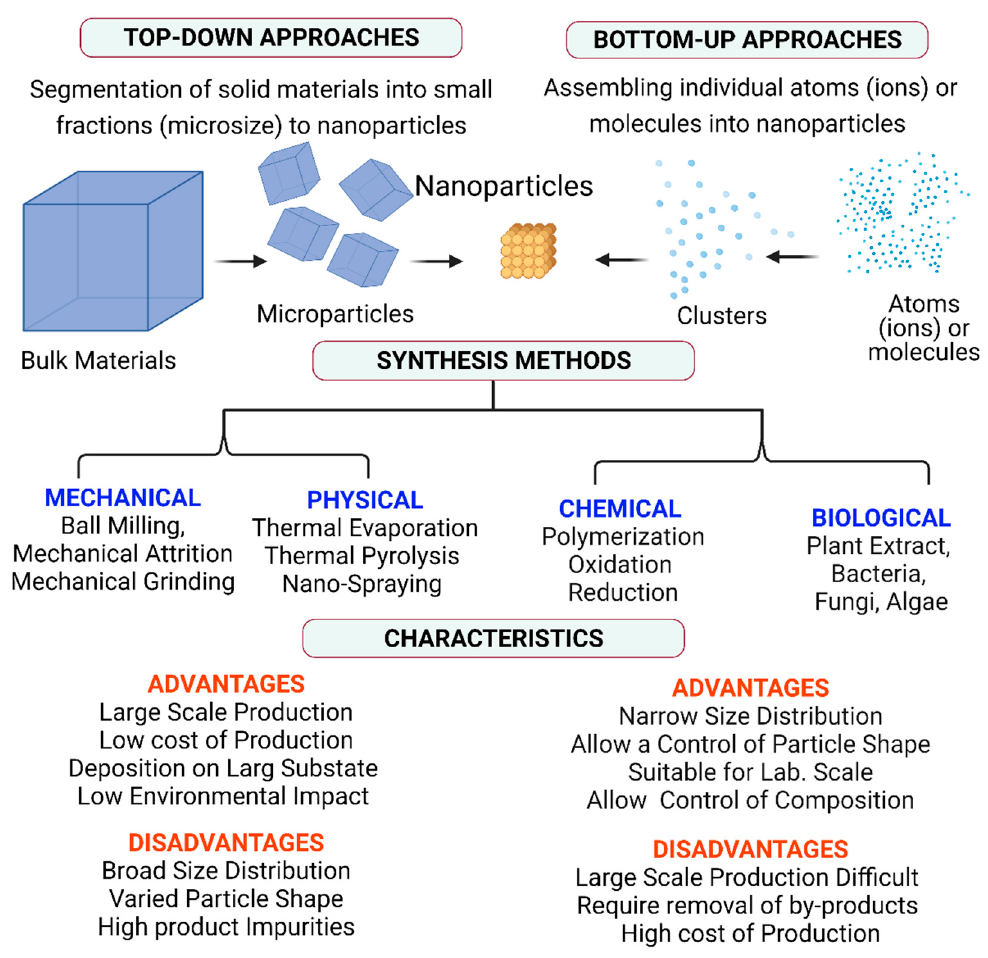
Figure 12. Schematic presentation showing of the different fabrication techniques to produce nano- materials and their advances and disadvantages.